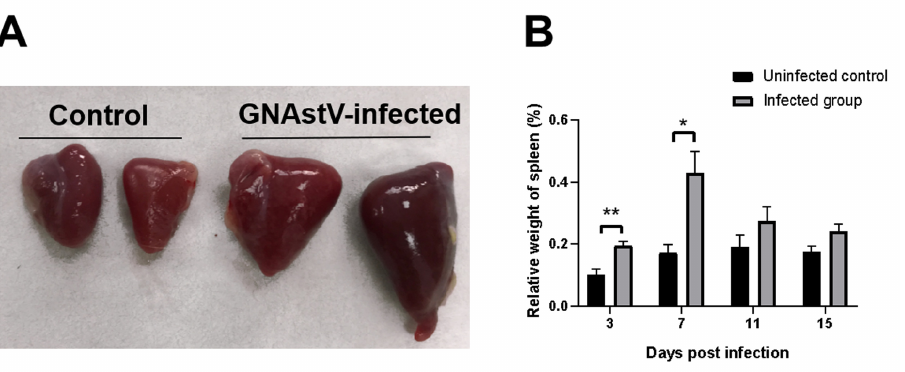
Figure 2. Infection with GNAstV induces gross morphological changes and increase in spleen weight in infected goslings. The spleens of the infected goslings were larger than in the control at 5 dpi ( A ). The relative weight of spleens was measured at 3, 7, 11, and 15 dpi ( B ). Values are expressed as mean ± SD, n = 5. * p < 0.05; ** p <